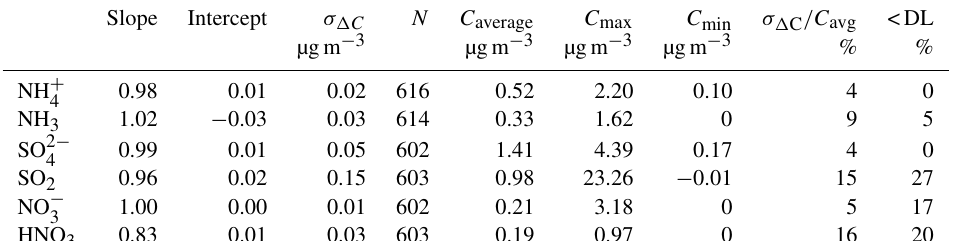
Table 2. Comparison between MARGA sample boxes 1 and 2 for particulate NO − by orthogonal least-squares regression. N is number of observations, C average is average air concentration, σ (cid:49) C is the standard deviation of the orthogonal least-squares residuals (i.e., detection limit; DL), σ (cid:49) C /C avg is the precision estimate, and C max and C min are the maximum and minimum air concentrations, respectively. Percentage of observations below the DL is also included.